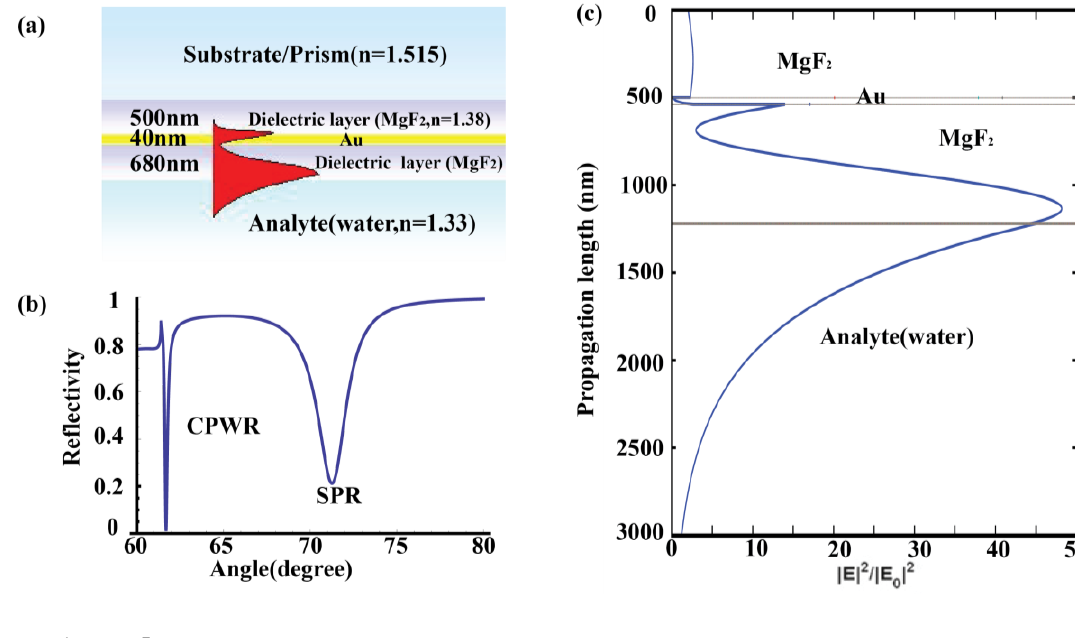
Figure 1. ( a ) 1D implementation of a symmetrical optical waveguide structure based on Kretschmann configuration for CPWR excitation. Theoretically calculated angular reflectivity curves ( b ) and electric field distributions ( c ) for the architecture given in ( a ) at the excitation wavelength of 632.8 nm, n(Au) = 0.3123 + 3.146i. Propagation length in this figure refers to the electric field decay distance away from the sensor surface into the analyte.